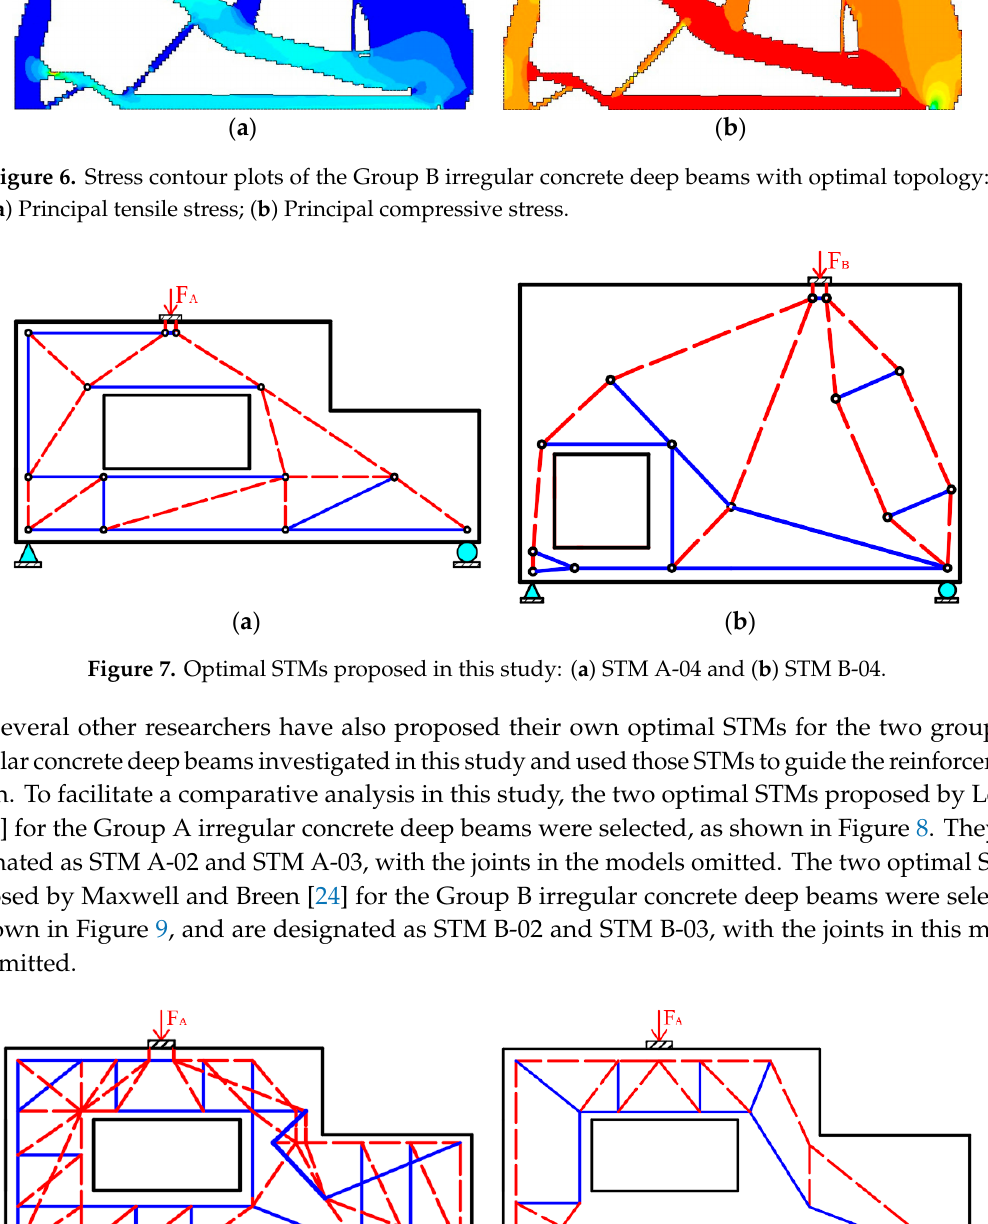
Figure 6. Stress contour plots of the Group B irregular concrete deep beams with optimal topology: ( a ) Principal tensile stress; ( b ) Principal compressive stress.